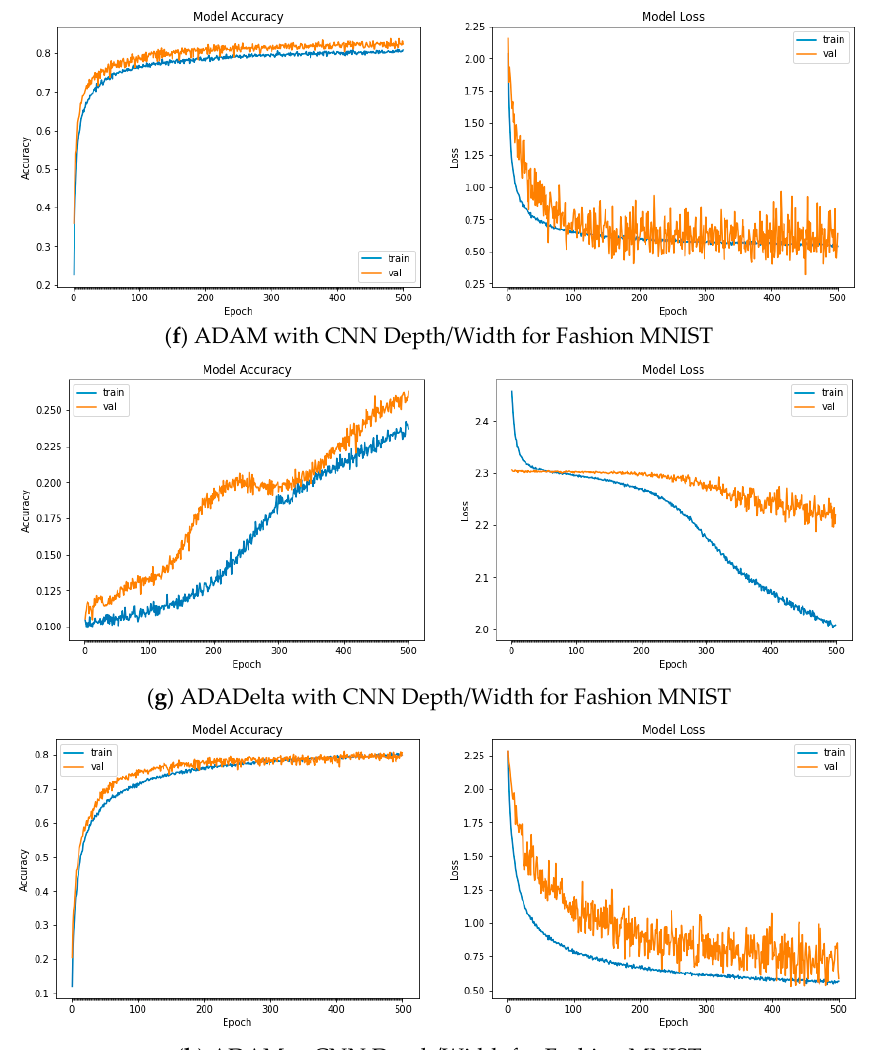
Figure A9. Plots of Train and Validation Test accuracies and losses of the CNN model with varying depth/width for Fashion MNIST: ( a ) Vanilla SGD; ( b ) SGD momentum; ( c ) SGD Nesterov momentum; ( d ) ADAGrad; ( e ) RSMProp; ( f ) ADAM; ( g ) ADADelta; ( h ) ADAMax.